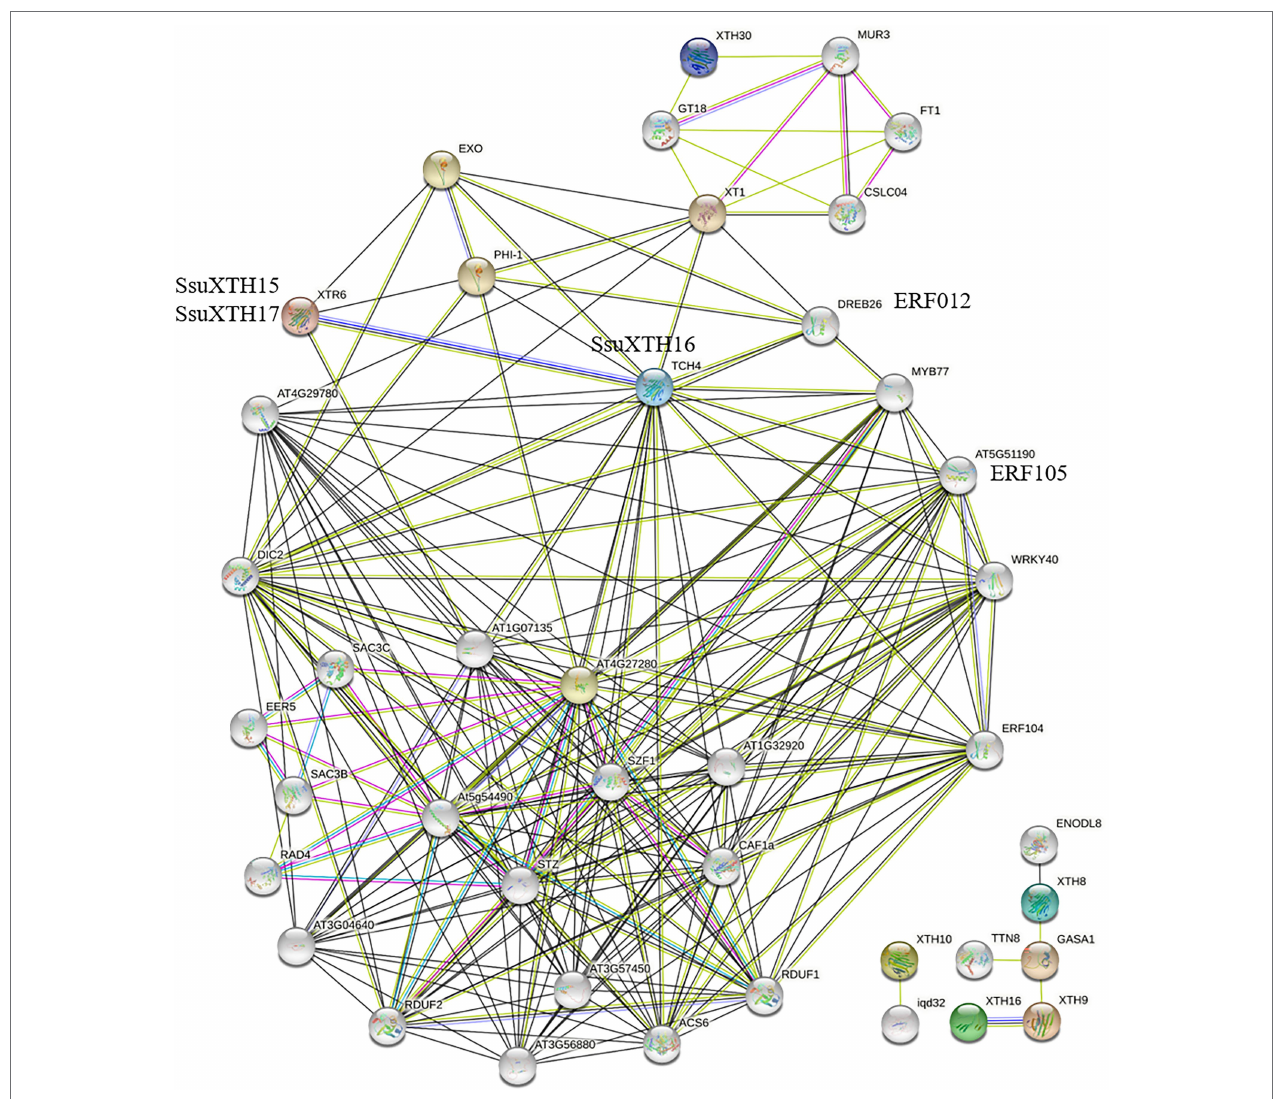
FIGURE 6 | Prediction of the functional interaction network of SsuXTH based on the orthologs in A. thaliana . The colored nodes: query proteins and first shell of interactors; White nodes: second shell of interactors; Light blue edges: known interactions from curated databases; Pink edges: known interactions experimentally determined; Green edges: predicted interactions with gene neighborhood; Red edges: predicted interactions with gene fusions; Blue edges: predicted interactions with gene co-occurrence; Blue edges: text mining; Black edges: coexpression; Purple edges: protein